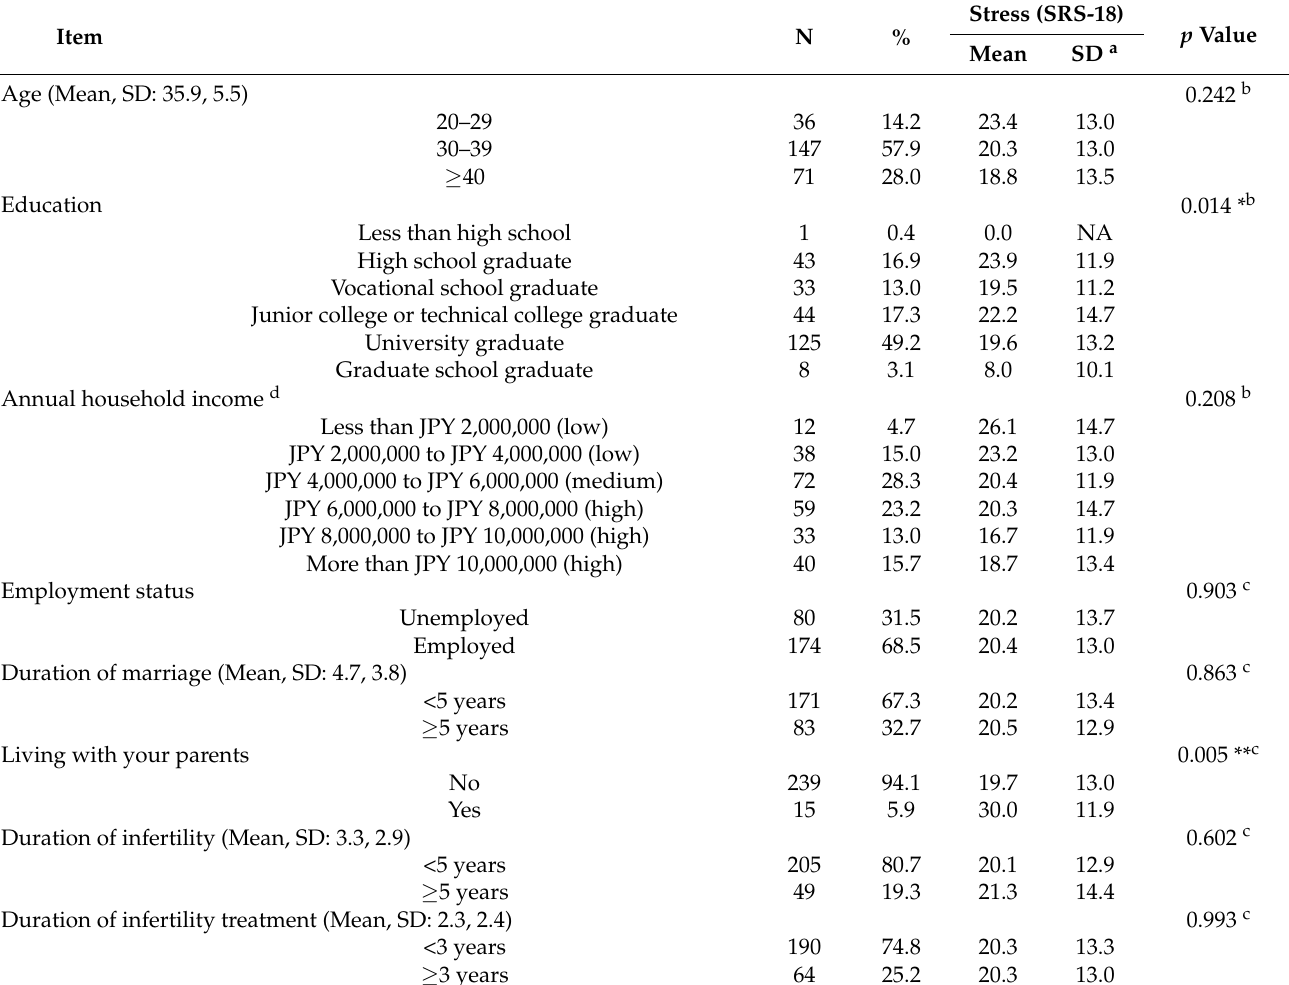
Table 1. Participants’ sociodemographic factors, clinical characteristics, and their association with stress responses. ( n =